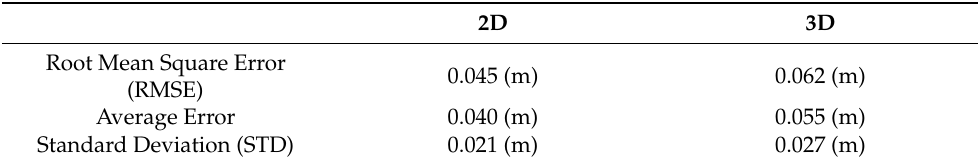
Figure 11. Results in Google Earth (from Google Earth). Figure 11 illustrates the converted elements in Google Earth, which only supports .kml files. To import the study results into Google Earth, the ASSURE Mapping tool was applied to transform the results in OpenDRIVE format to the Google Earth format. Since Google Earth map does not display lane width, the converted results retained only pol- ylines that presented centerlines. After the conversion of the HD map, the centerline of each lane almost fit the satellite image. CARLA, a free and open-source simulator that allows people to import simulated scenes into it, supports simulations of OpenDRIVE files; furthermore, it can launch a driv- ing scenario in these simulated scenes. Some researchers use this simulator for platform testing and for simulating the performance of algorithms for self-driving cars. The